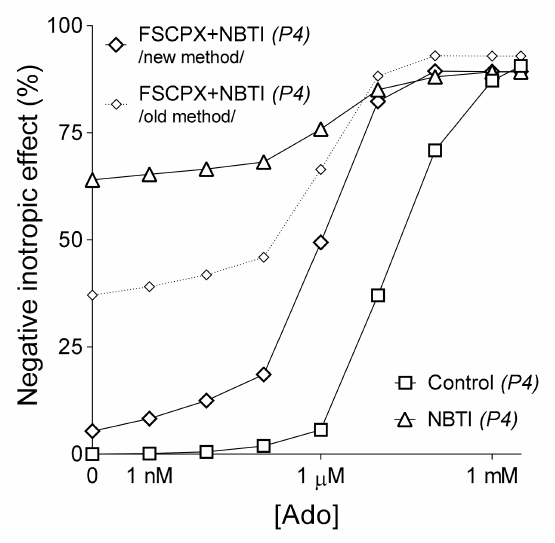
Figure 4. The corrected effect values of the adenosine concentration-response ( E / c ) curves in the P4 group constructed in the presence of NBTI (without and with a previous FSCPX pre-treatment), furthermore the original effect values of the averaged, control adenosine E / c curve in the P4 group (considered to be inherently correct). The applied (pre)treatments and the experimental group ( latter one in italics ) are indicated. The x -axis shows the adenosine concentrations (in the bathing medium) on a logarithmic scale and the y -axis indicates the effect (as a percentage decrease of the initial contractile force). The symbols represent the responses to adenosine averaged within the groups. Nota bene: While effect values of E / c curves generated in the presence of NBTI (no matter with or without FSCPX) were evoked by adenosine of both (exogenous and endogenous) origins, they could be plotted only versus the exogenous adenosine levels in the bathing medium of atria. New method: our receptor reserve-estimating method used in its improved form; old method: our receptor reserve-estimating method applied in its original form [18]; Ado: Adenosine; NBTI: S -(2-hydroxy-5-nitrobenzyl)-6-thioinosine;